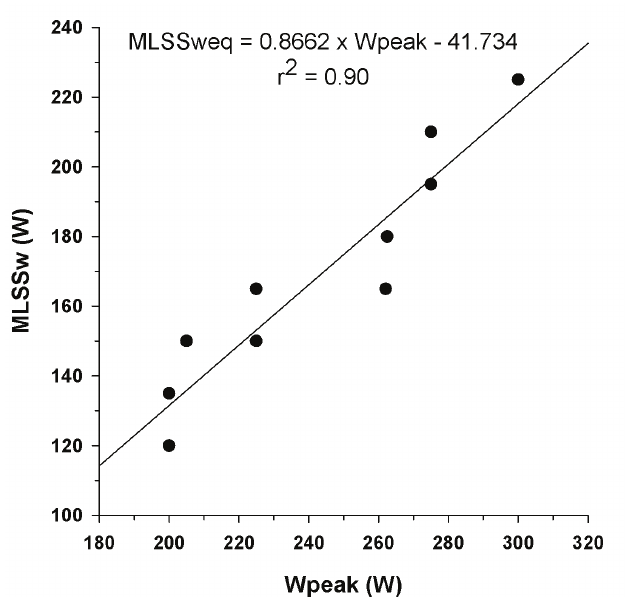
Figure 2. Linear regression between maximal power output (W power output at MLSS (MLSSw) for participants in group 1.